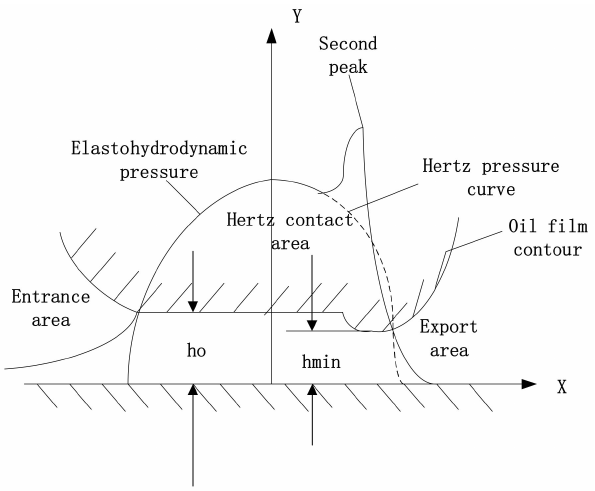
Figure 8. Elasto-hydrodynamic pressure distribution of inter-shaft